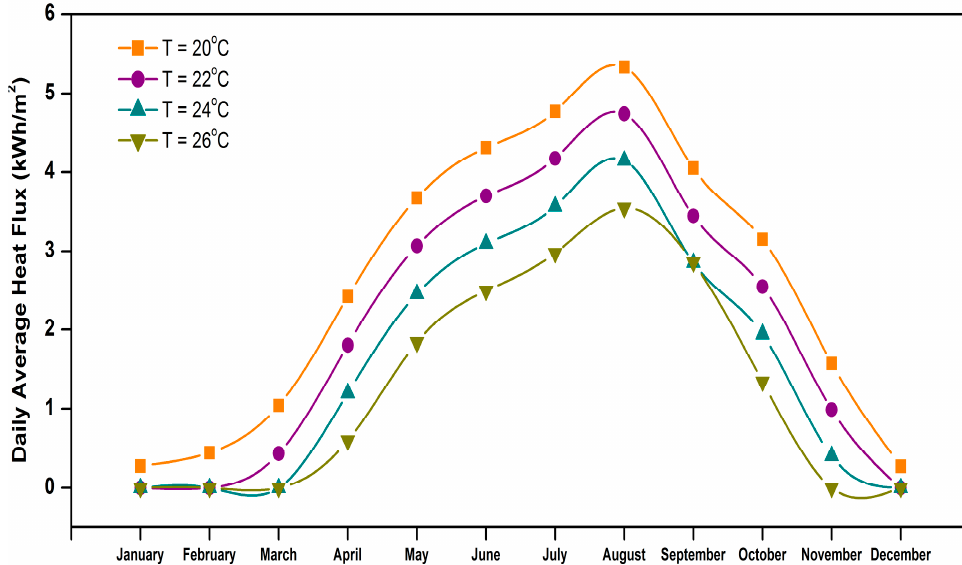
Figure 17. Effect of AC set point temperature on average heat flow through high SRI surface.